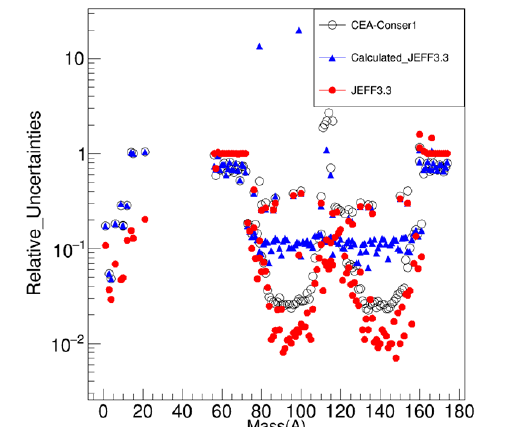
Fig. 20. Relative uncertainties of chain yields as a function of mass for the “conservative 1” evaluation.